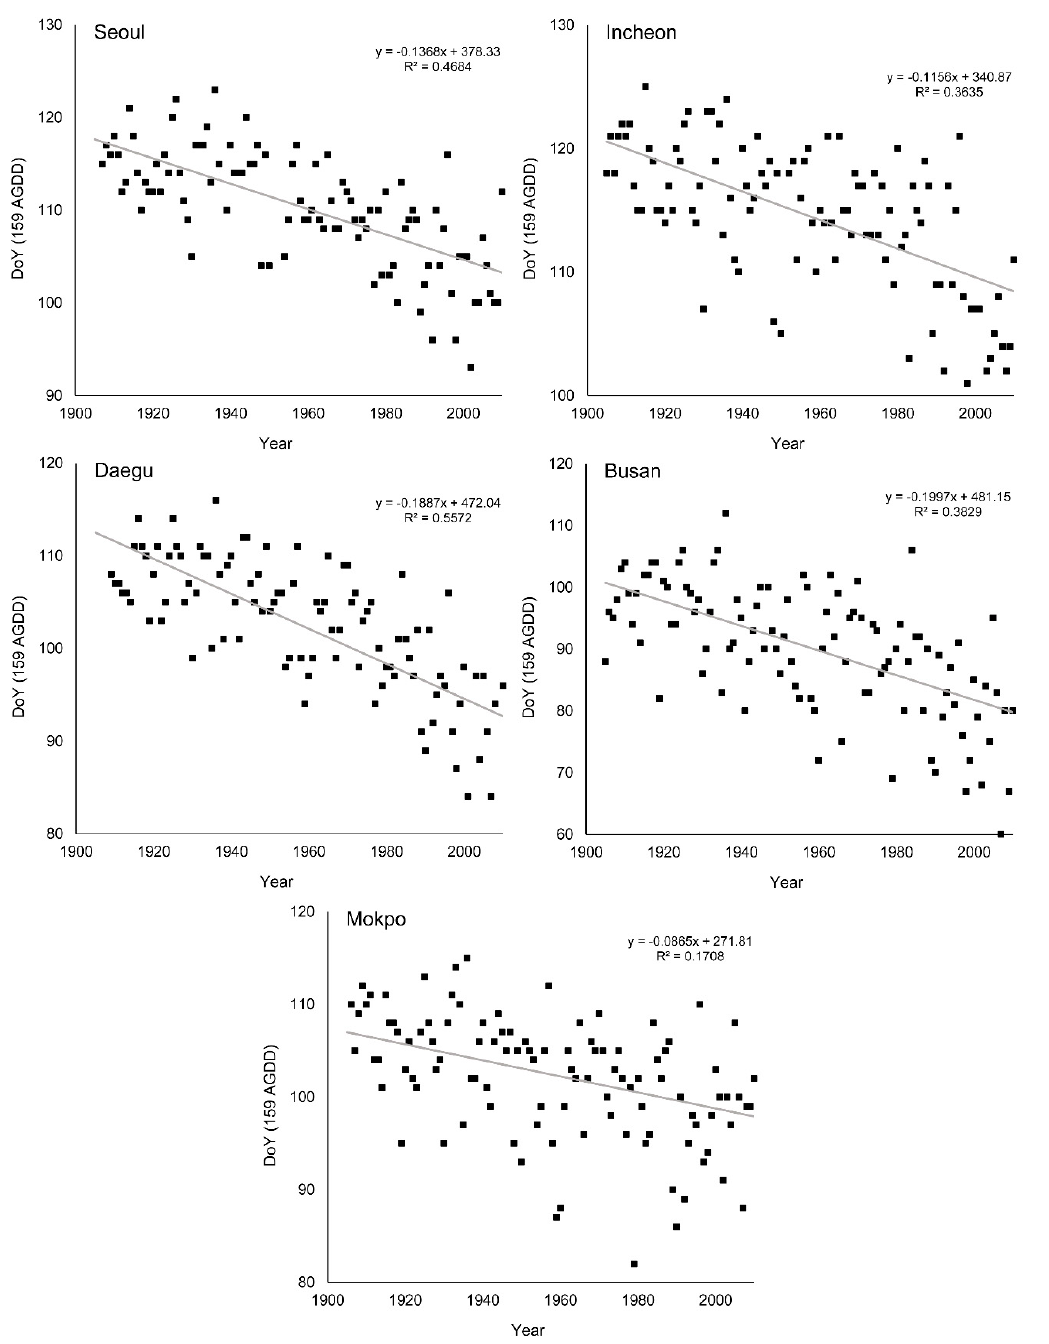
Figure 10. Changes of the simulated green-up dates of Mongolian oak, which require 159 AGDD during the past century using the air temperature measured in the meteorological stations in major cities of South Korea.